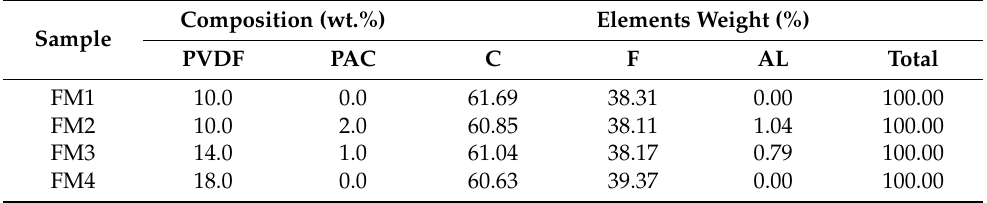
Table 5. Elemental compositions of selected PVDF-PAC fabricated membranes based on EDX map- ping.